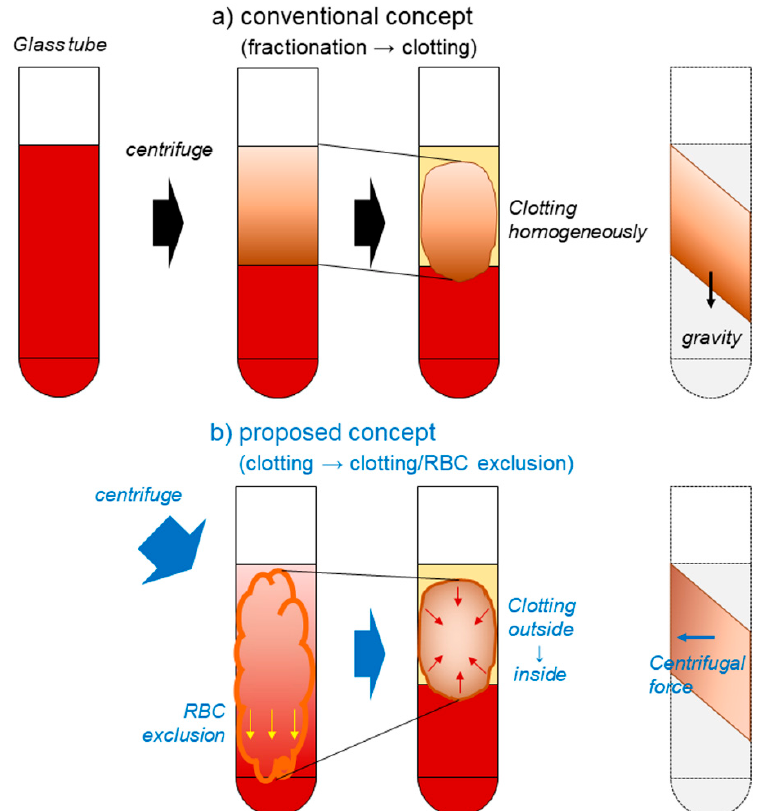
Figure 5. Schematic representation of PRF formation during centrifugation and the resulting platelet accumulation in specific regions of PRF matrices. ( a ) According to the conventional and widely-accepted concept, specific gravity-dependent fractionation precedes coagulation almost homogenously. Thus, the gradation of platelet density is preserved in PRF matrices. ( b ) In our proposed concept, coagulation occurs from the outside, a little earlier than fractionation. Thus, platelets entrapped loosely in gradually clotting PRF matrices are accumulated in the distal peripheral region. This proposed mechanism is consistent with our observations.